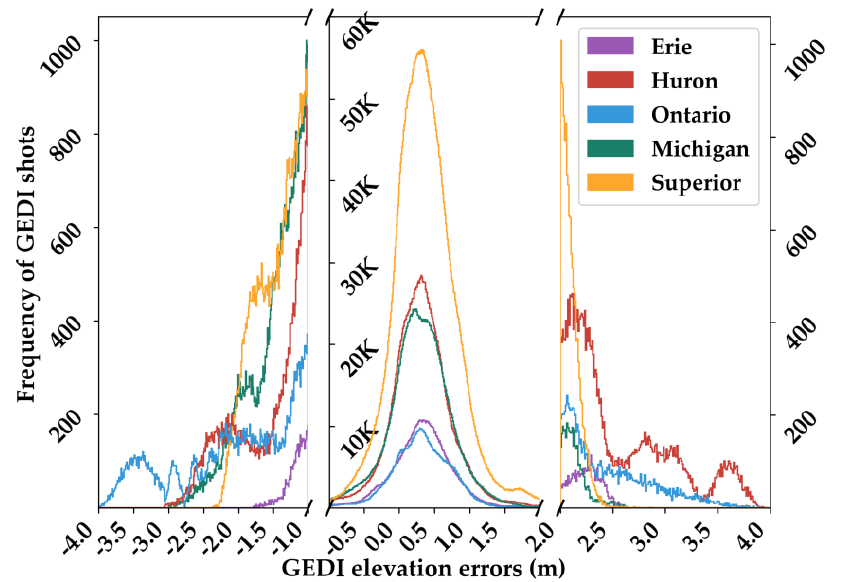
Figure 13. Distribution of GEDI elevation errors across the five studied lakes.